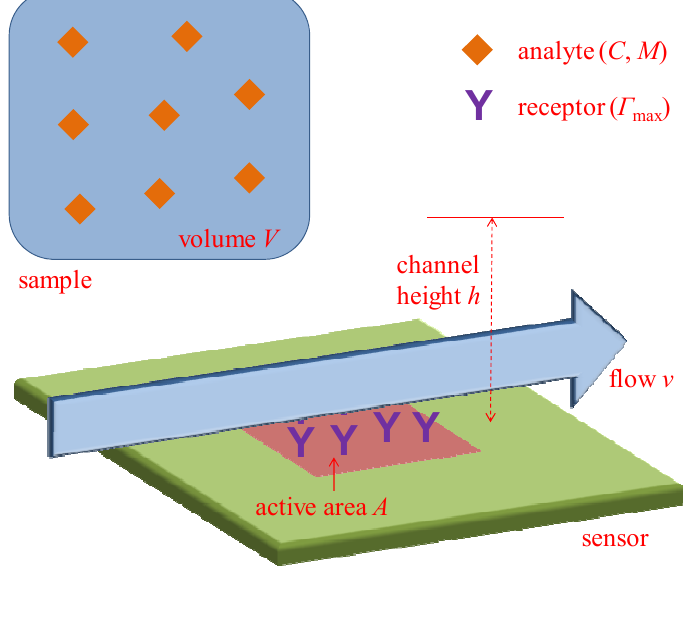
Figure 1. The principle of a surface-based sensor system operating in vitro . On the active area A there are recognition elements for the target analyte, which has molecular weight M and is present in a sample of volume V at concentration C . The sample solution is introduced to the surface in a channel with height h , possibly with continuous flow at an average velocity v . The maximum surface coverage of the analyte Γ number of receptors (and M